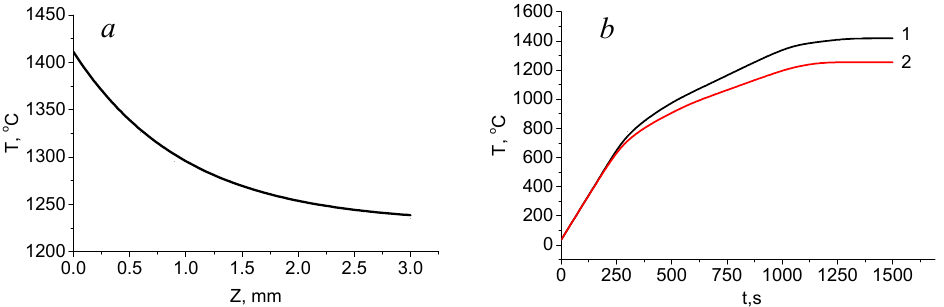
Figure 5. ( a ) Temperature distribution as a function of depth, with an uneven distribution of layers. ( b ) Temperature time dependencies of the (1) irradiated and (2) non-irradiated sides. A decrease in the thickness of layers containing ZrO 2 leads to a smaller temperature drop across the sample upon reaching the ZrO 2 and Al 2 O 3 sintering temperatures. Figure 6 shows the dependence of the temperature drop on the temperature of the irradiated side for four-layer samples during heating and cooling. The direction of the process is shown in the figure by